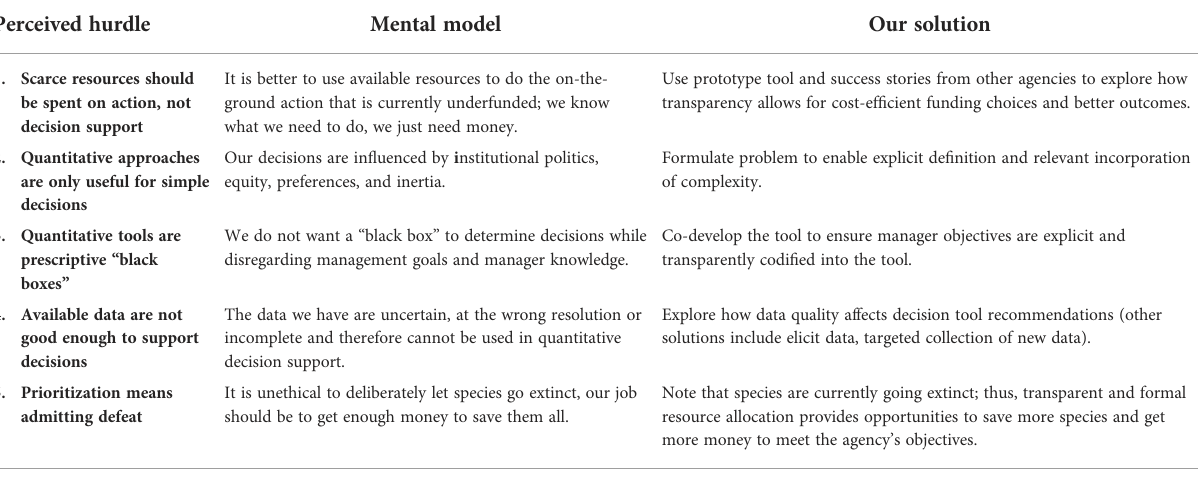
TABLE 1 Perceived hurdles to using quantitative decision tools to support allocation of endangered species recovery funding. Perceived hurdle Mental